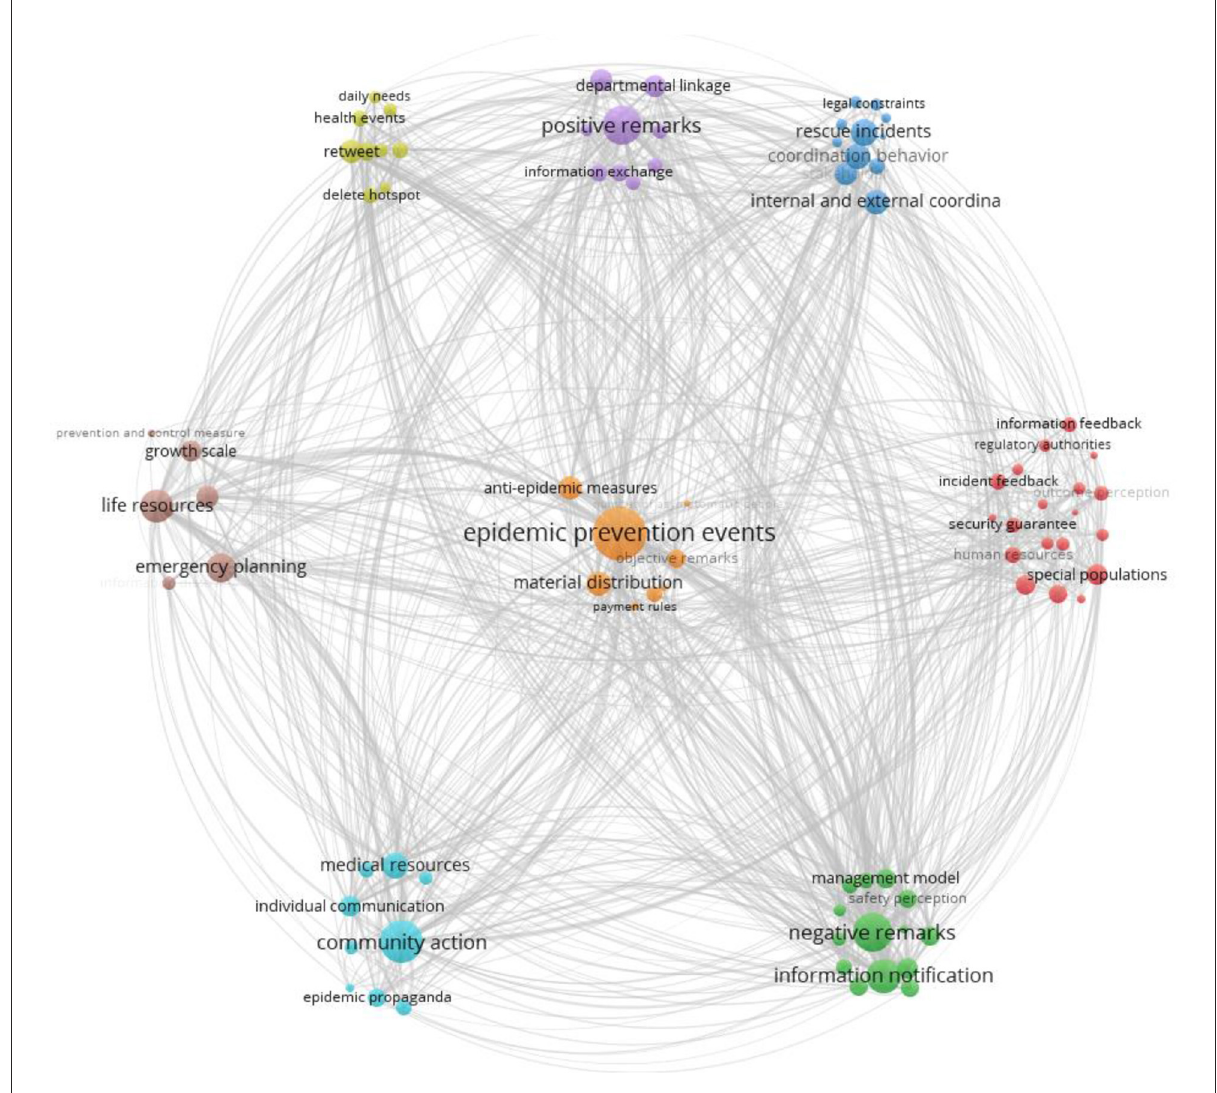
FIGURE5 Category correlation